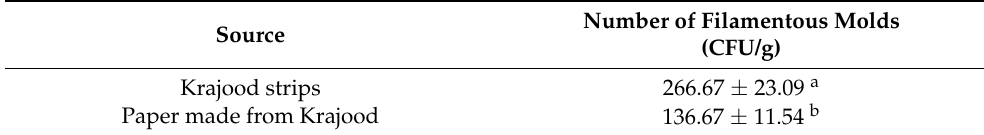
Table 2. Numbers of filamentous molds from Krajood strips and papers made from